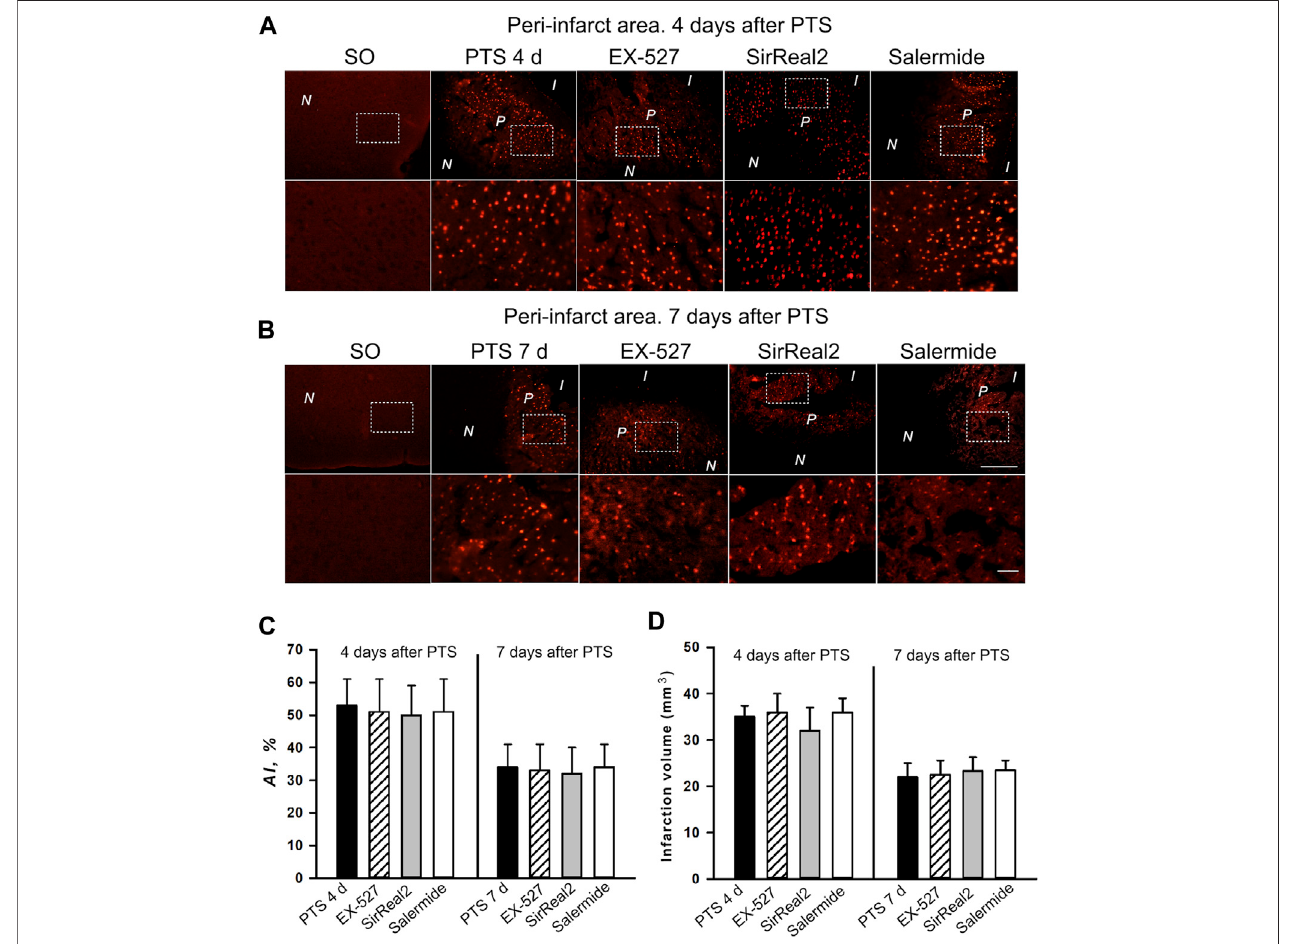
FIGURE 8 | Apoptosis in the PTS-induced peri-infarct area in the mouse cerebral cortex. (A,B) Typical images of cortical regions stained with TUNEL (red fl uorescence) at 4 days (A) and 7 days (B) after PTS. Control: sham-operated animals (SO). Experimental groups: The cerebral cortex of mice injected by various inhibitors.Inhibitors:EX-527,aselectiveSIRT1inhibitor;SirReal2,aselectiveSIRT2inhibitor;salermide,anonspeci fi cinhibitorofSIRT1andSIRT2.Scalebar200 μ m (C) Changesintheapoptoticindex(AI,%)inthemiceofexperimentalgroupsonday4and7afterphotothromboticstrokeandintroductionofvariousinhibitors. (D) The effects of SIRT1 and SIRT2 inhibitors on the infarction core volume in the mouse brain at 4 and 7 days after photothrombotic stroke. Mean values of the infarction core volume(mm 3 ) in the control group (PTS without inhibitors) and in the experimental groups (administration of inhibitors). Scale bar 1 cm. One Way ANOVA; M ± SEM; n = 7 – 10. * p < 0.05 compared with the PTS in the absence of